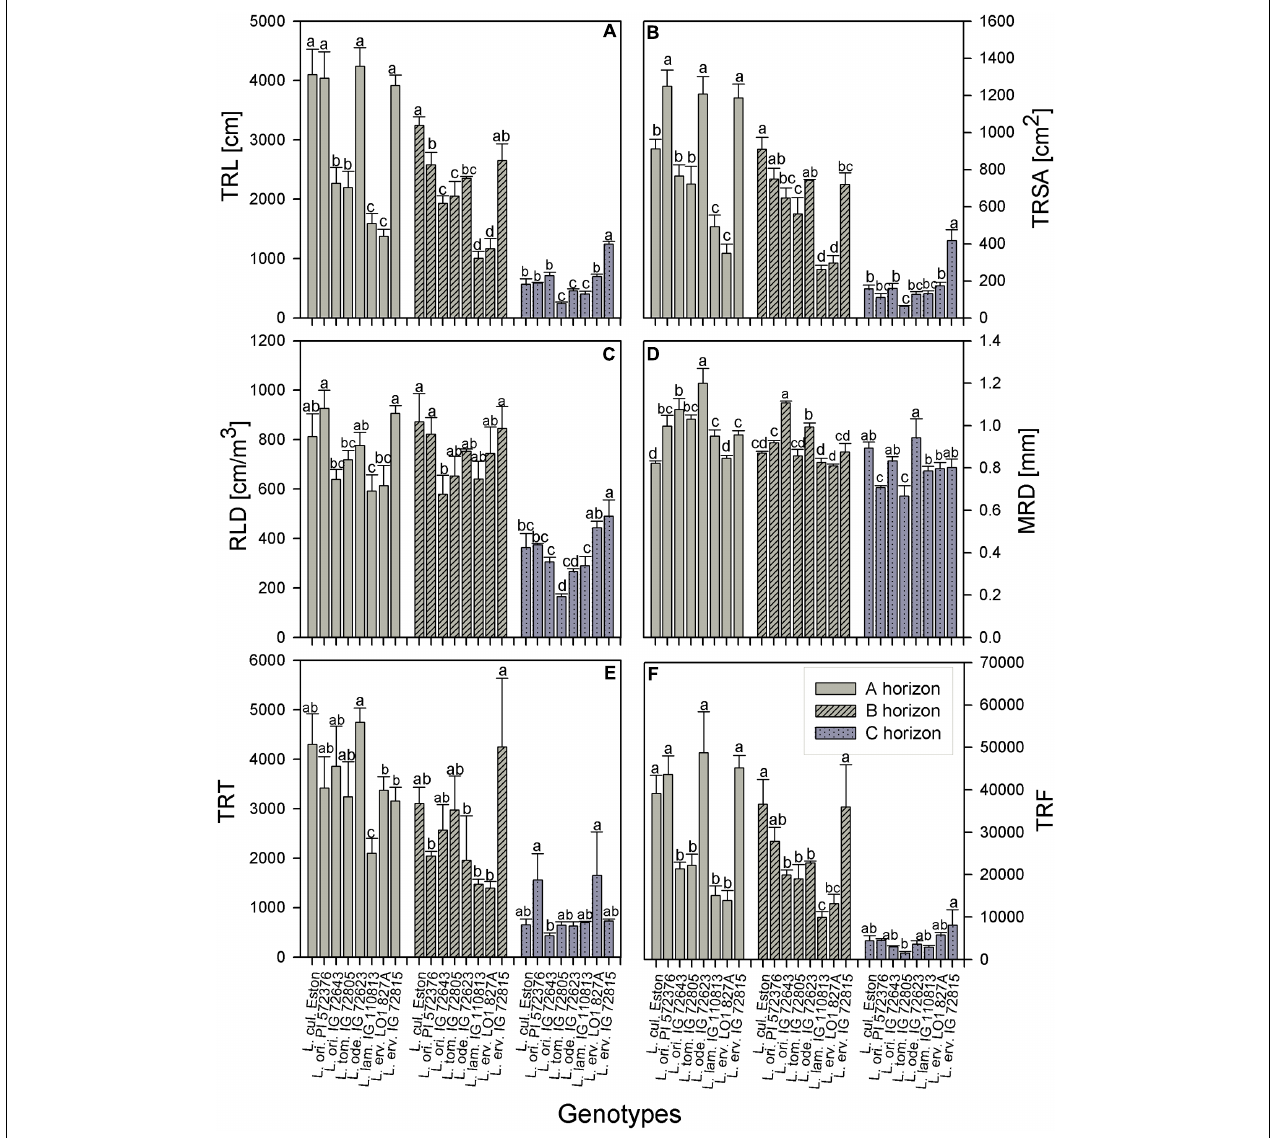
FIGURE 3 | Comparison of root trait characteristics in three soil horizons for Lens culinaris Eston and five wild lentil species grown under fully watered conditions. Bars denote standard error. Letters denote significant differences at α = 5% for genotypes in the same soil horizon. (A) TRL, total root length; (B) TRSA, total root surface area; (C) RLD, root length density; (D) MRD, mean root diameter; (E) TRT, total number of root tips; (F) TRF, total number of root forks.